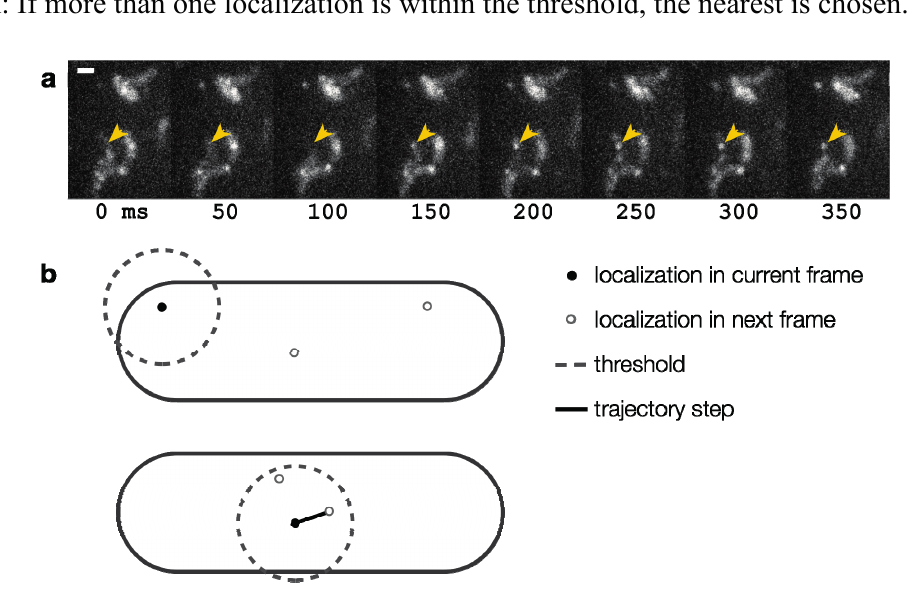
Figure 10. ( a ) Time-lapse images of diffusing TcpP-PAmCherry molecules in live V. cholerae cells. The arrowhead highlights one molecule, which turns on in the fourth panel and moves inside the cell. Each panel is 50 ms. Scale bar: 1 µm; ( b ) Implementing a step size threshold (dashed line). Top: The black molecule cannot be connected to either molecular position in the next frame because they are both beyond the maximum step size. Bottom: If more than one localization is within the threshold, the nearest is